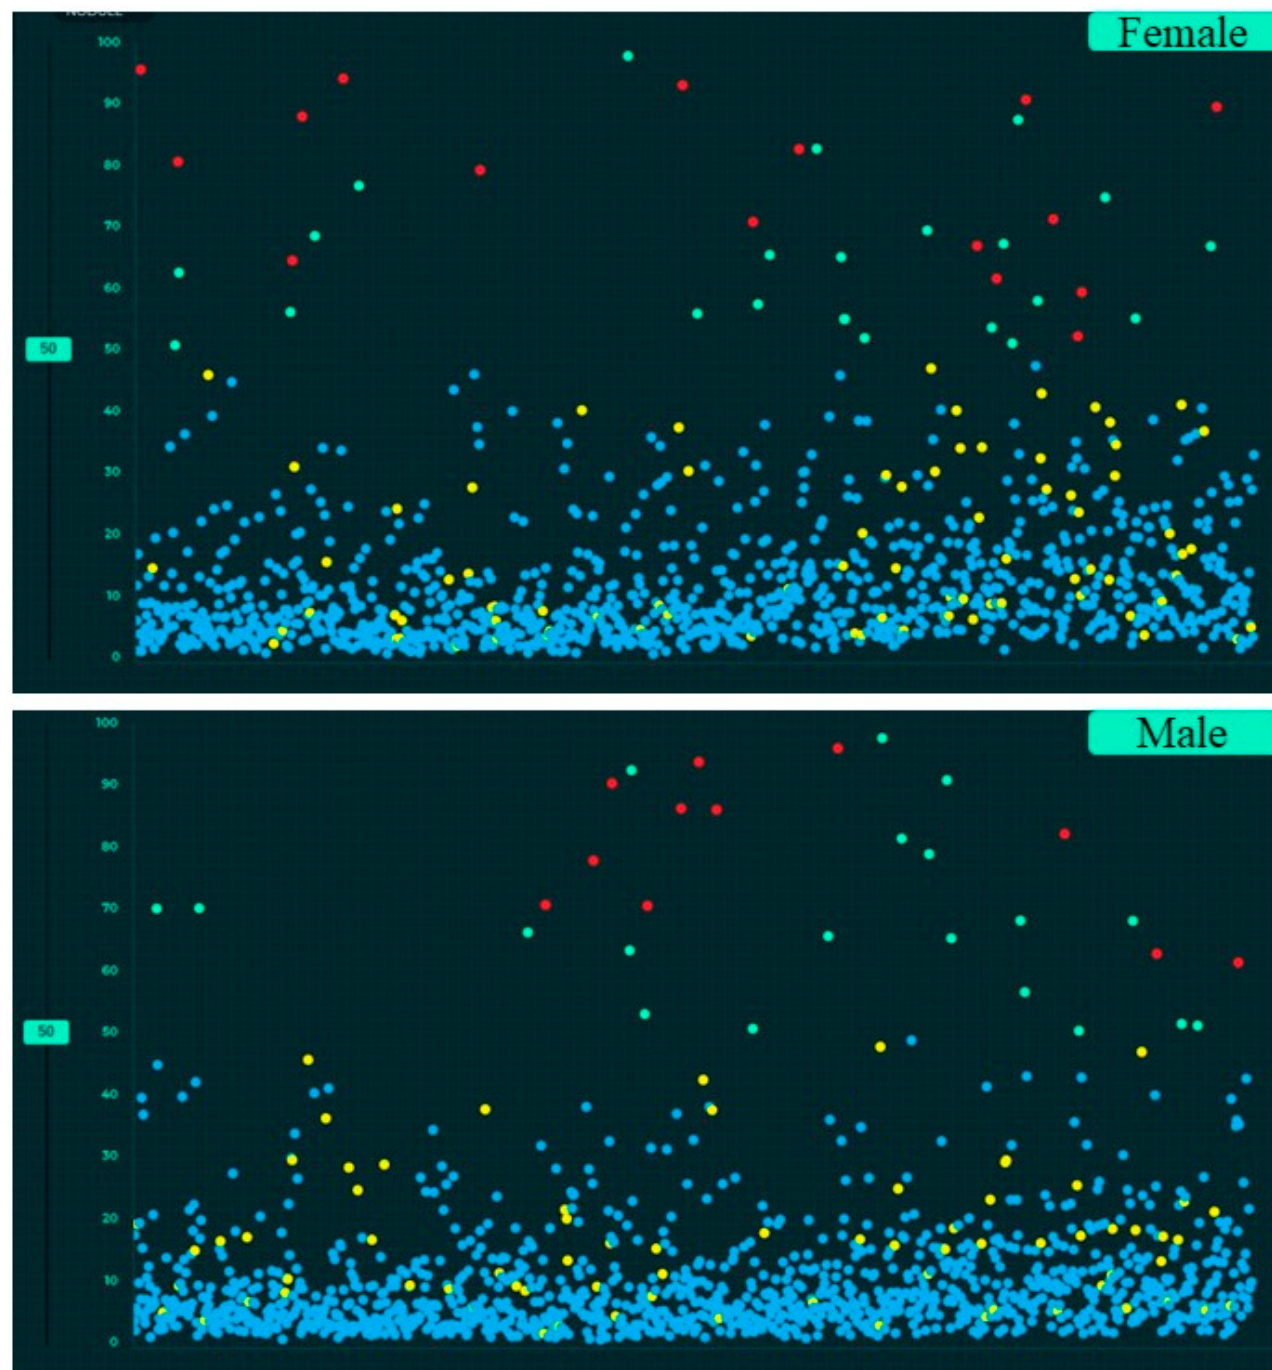
Figure 6. Screen captures of the AI validation interface illustrating the scatterplots of AI output for gender-wise distribution of CXR findings (true positive (red dots), true negative (blue dots), false negative (yellow dots) and false positive (green dots)).